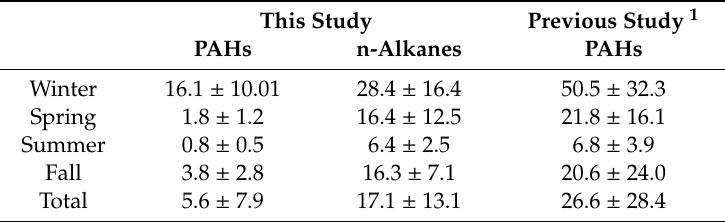
Table 3. Comparison of PAHs and n-Alkane levels with a previous study in 2002 (unit: ng m − 3 ). This Study